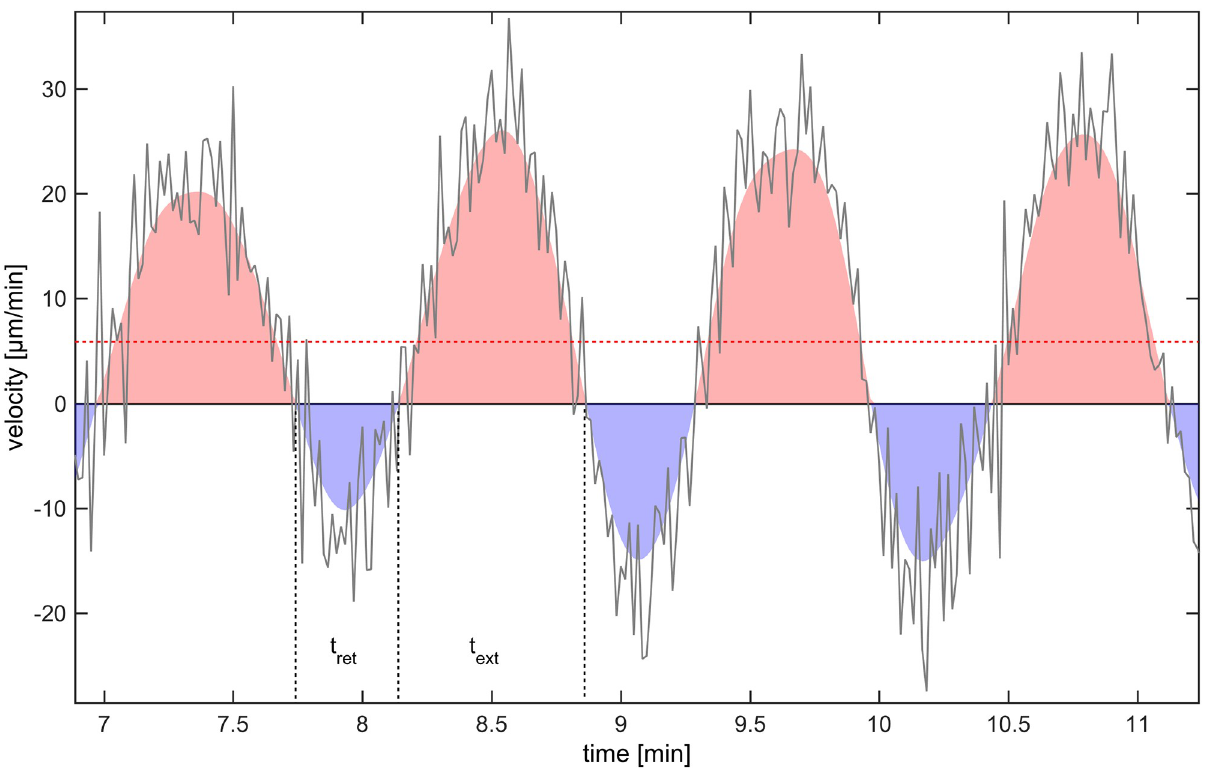
Fig 3. Movement speed of frontal membrane. Red dashed line = average velocity. Negative values = movement of cell contour towards center of mass. t ret = membrane retraction time, t ext = membrane extension time.